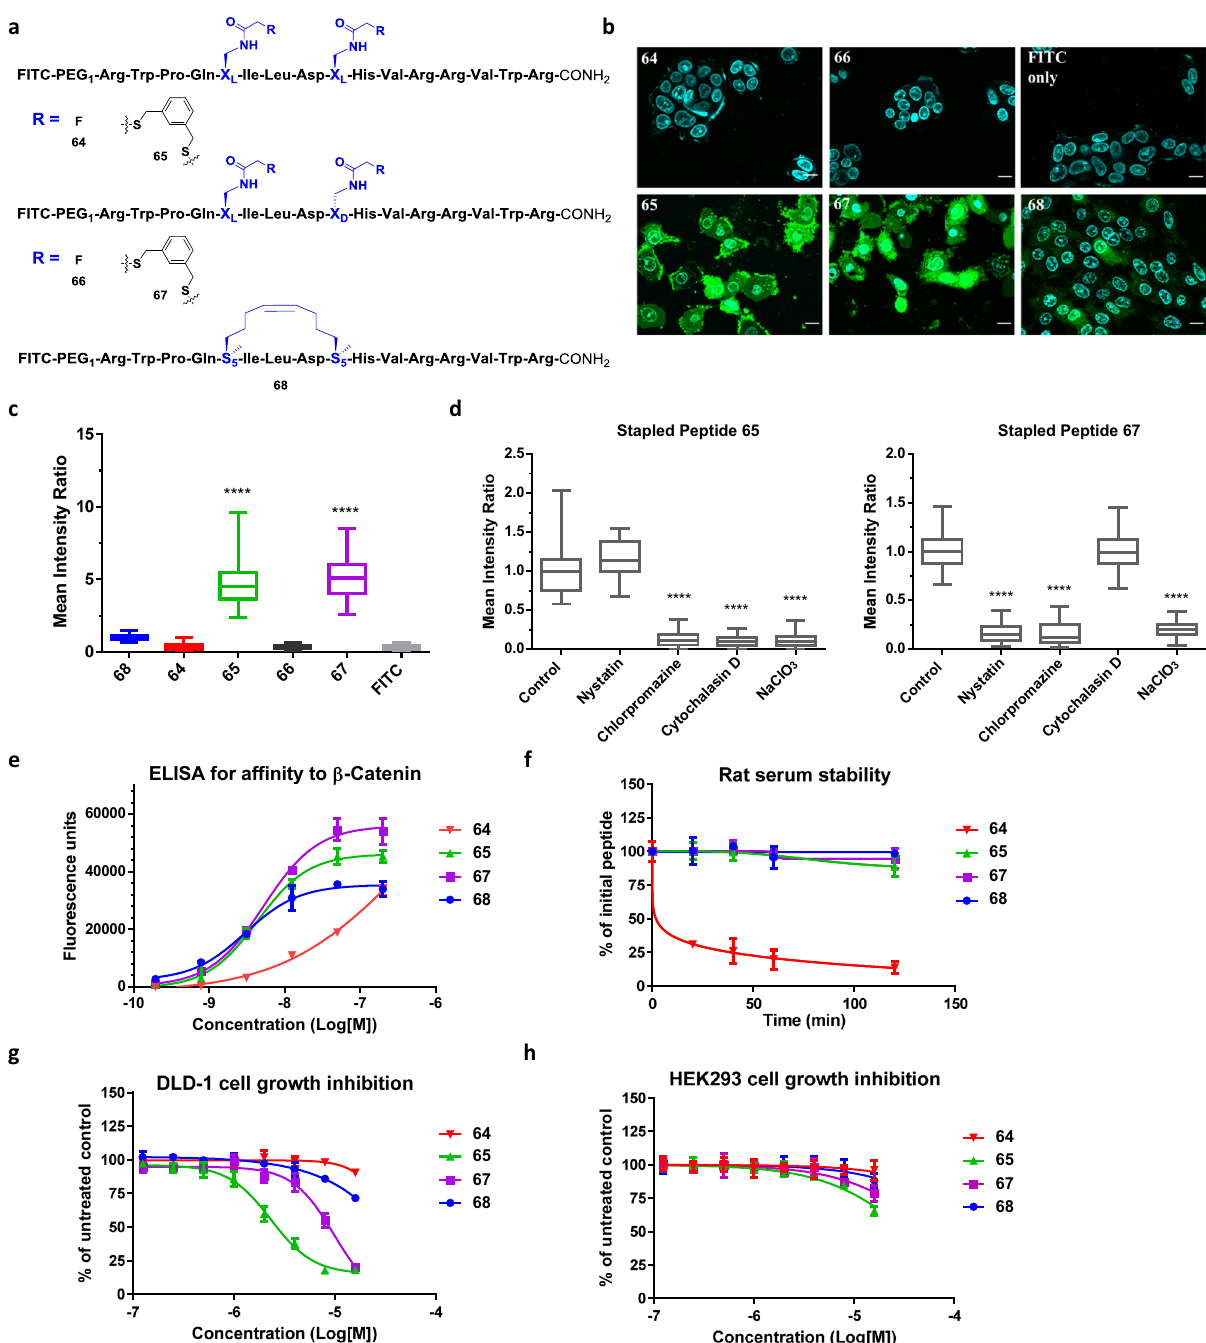
Fig. 7 FTDR-stapled functional Axin peptide analogues. a Chemical structures of peptides 64 – 67 . The Axin peptide analogue 68 (stapled by RCM and reported for cell penetration studies) was prepared as well. Stapling residues X L /X D /S 5 are highlighted in blue. b Fluorescent confocal microscopy images of the DLD-1 cells treated with peptides 64 – 68 and FITC only as a negative control. Blue: nucleus stained by Hoechst 33342; Green: FITC; Scale bar: 5 μ m. c Quanti fi cation analysis of the cell penetration of peptides 64 – 68 . The mean intracellular intensity of peptide 68 was normalized as 1. “ **** ” Represents p < 0.0001. d Quanti fi cation analysis of the cell penetration of peptide 65 or 67 after the cells had been treated with blockers of endocytic pathways. The mean intracellular intensity of peptides in cells untreated with any blocker was normalized as 1. See SI for fl uorescent microscopy images. “ **** ” Represents p < 0.0001. For c and d , box plots show 25 – 75% quantiles, median values (bullseye), and minimal and maximal values (whiskers). Two-sided unpaired t test with Welch ’ s correction has been applied. Detailed sample sizes, mean ± SEM values are available at Supplementary Tables 8 – 10. e The binding af fi nity of unstapled ( 64 ) and stapled Axin peptide analogues ( 65 – 68 ) to the target β -catenin protein. f The stability of the aforementioned peptide analogues in 100% rat serum. g – h The inhibition of these peptide analogues on the 5-day growth of DLD-1 cancer cells ( g ) and HEK293 control cells ( h ). Data plots in panels e - h are mean values ± standard deviation (SD) measured from n = 3 biologically independent